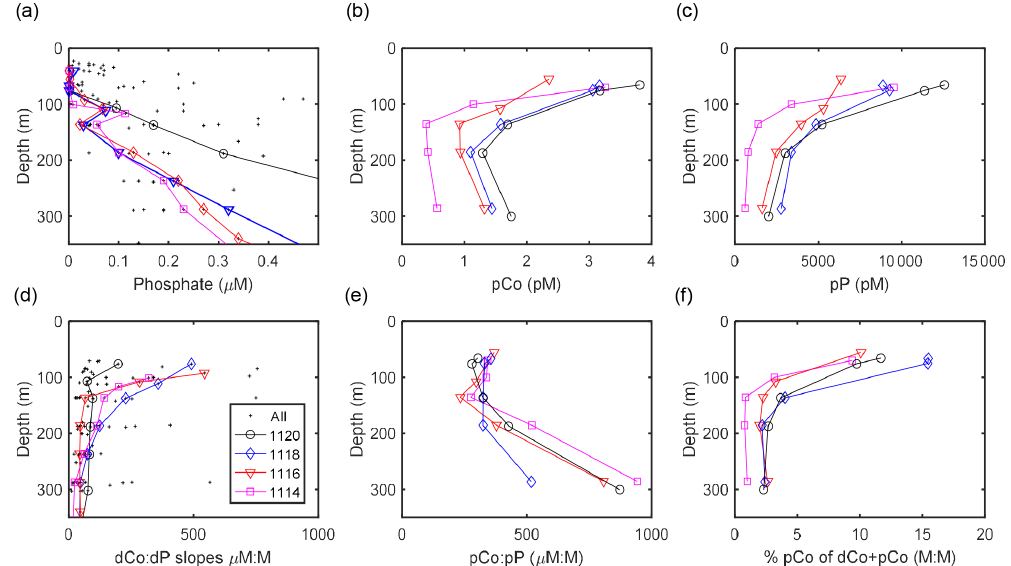
Figure 7. Dissolved (dCo) and particulate ( p P) cobalt and phosphate concentrations and ratios at subtropical gyres stations 14, 16, 18, and 20 from USGT-2011. (a) Phosphate profiles in the upper 350m for these four stations were low compared to all stations on the GA03/3_e expedition (small dots). (b) Particulate cobalt ( p Co) profiles (from the Go-Flo filters). (c) Particulate phosphate ( p P) profiles (from the Go-Flo filters). (d) dCo:P slopes generated by profile-regression analyses towards the surface, where each depth represents the mid-point of five depths used in the profile regression. (e) Ratios of p Co: p P decrease towards the surface as they transition from being dominated by manganese oxide particles at depth, but remain high relative to dissolved stoichiometries (Table 1) and culture studies at values of ∼ 350– 400µmolmol − 1 . (f) Percent of p Co of the cobalt inventory (dCo + p Co) revealed p Co to reach values as high as ∼ 10% in the upper euphotic zone, providing greater leverage for altering the dCo:dP